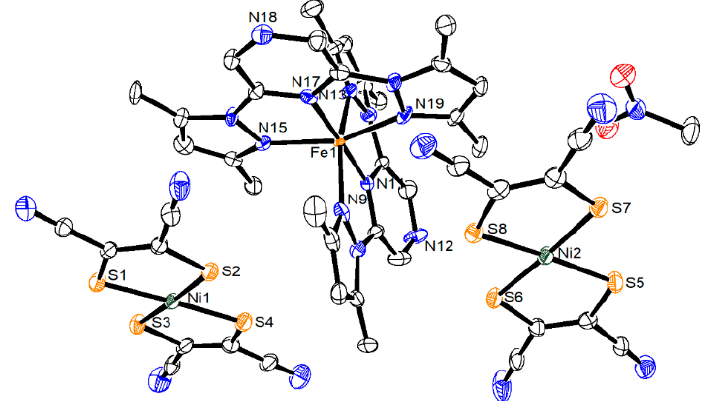
Figure 2. The molecular structure of compound 2 at 100 K, in the ORTEP [29] style with 50% thermal ellipsoids and atom numbering scheme. H atoms have been omitted for clarity.